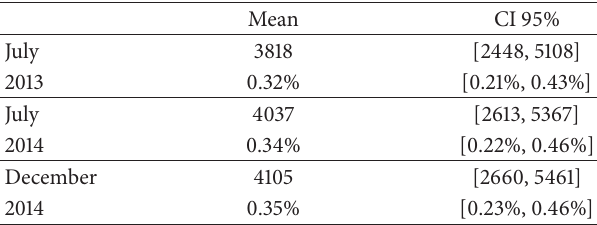
Table 11: Mean and CI 95% of the residual infected smartphones in July 2013, July 2014, and December 2014 in the community of Valencia and the corresponding percentages predicted by themodel.